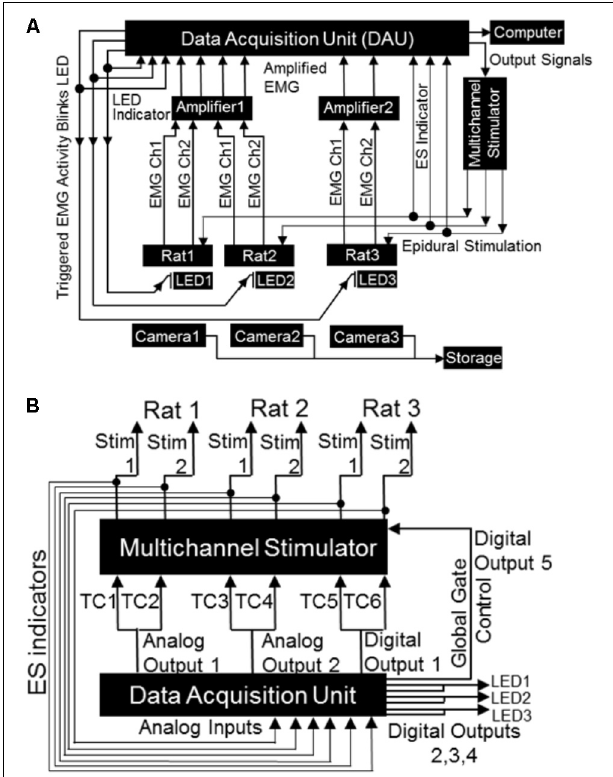
FIGURE 4 | Block diagrams depicting electrical connections of the mobile closed-loop spinal ES system. (A) Shown is a setup for a non-mobile closed-loop ES system for three rats. Detected EMG signal (shown are two EMG channels per rat) from implanted electrodes is amplified and sent to the DAU. When the EMG signal crosses a user defined threshold, the DAU triggers the multi-channel stimulator and synchronizing LED. A head plug cable transmits the stimulation pulse to the rat’s spinal cord. The synchronizing LED pulse is visible as a bright light on the camera each time the EMG signal crosses the threshold. Concurrent inputs into the DAU monitors the LED pulse as well as sends output signals to the stimulator. A computer records all inputs that is fed into the DAU (EMG signal, LED pulse, stimulation pulse). An infrared camera records rat activity throughout the long-term night experiments. (B) Expanded block diagram from (A) above shows detailed connections and ES indicator loops from the DAU to the stimulator. Included are the global gate output control for the stimulator, the LED outputs and LED indicator loops (TC: stimulator trigger input